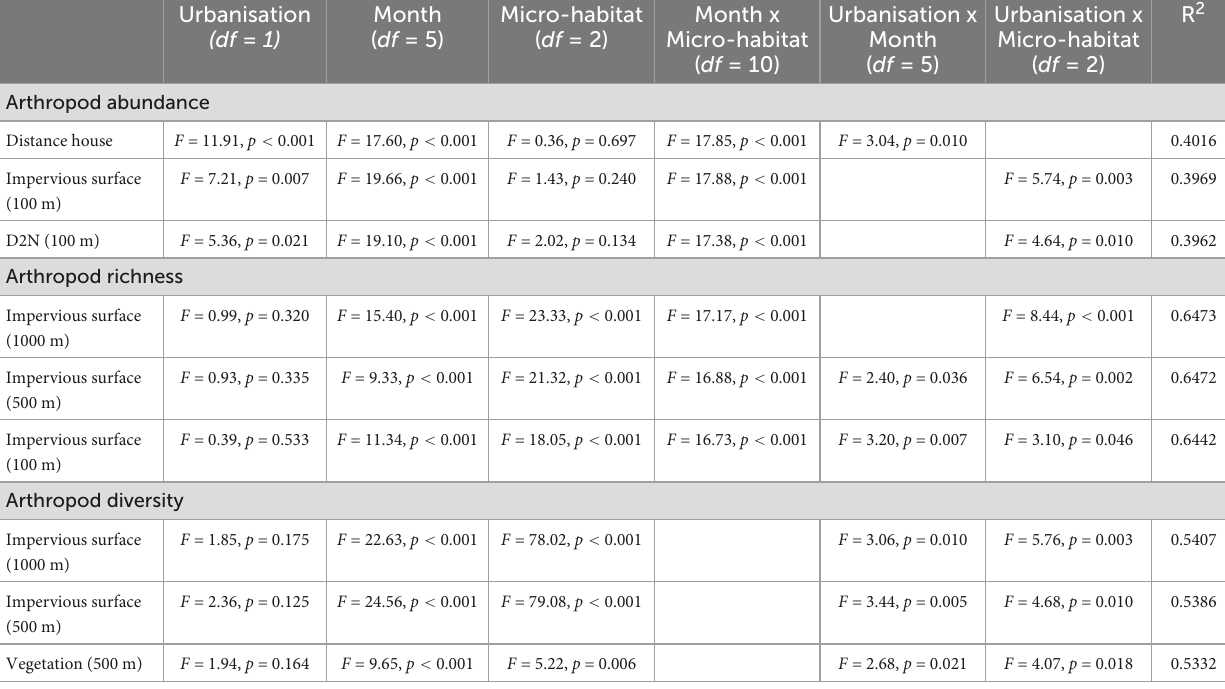
TABLE 1A Results of the final models explaining arthropod abundance, richness and diversity (Shannon diversity index) as a response to urbanisation level, the month (i.e., October, December, February, April, June and August), and the micro-habitat (i.e., canopy, bush layer and tree bark).